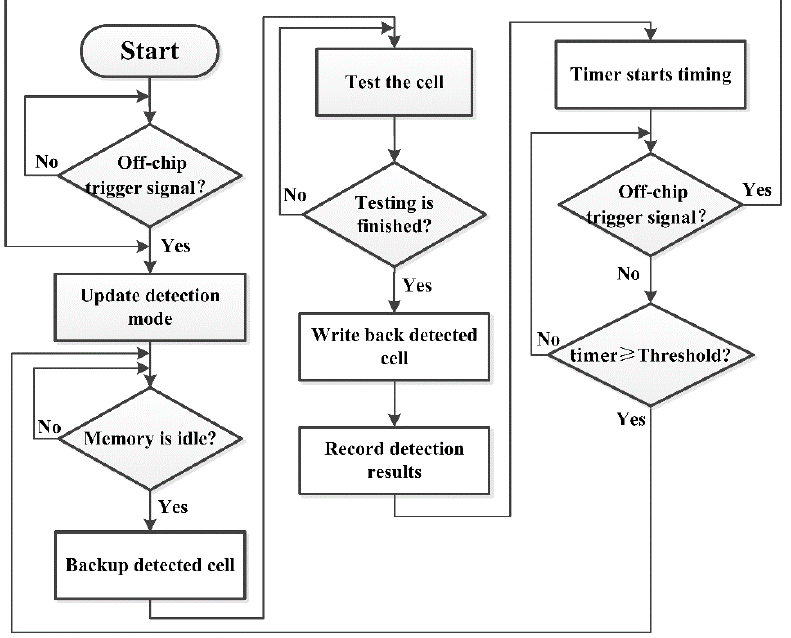
Figure 4. The workflow of the RDAMS.